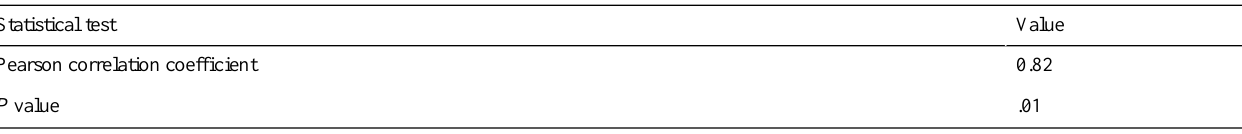
Table 3. Summary of statistical calculations for 8 virtual test subjects. a